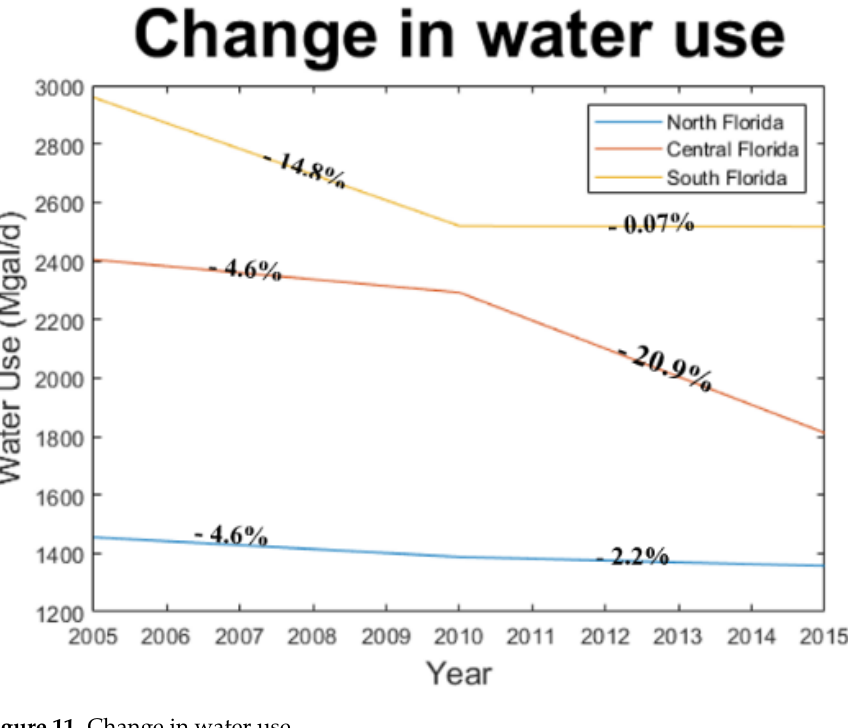
Figure 11. Change in water use.